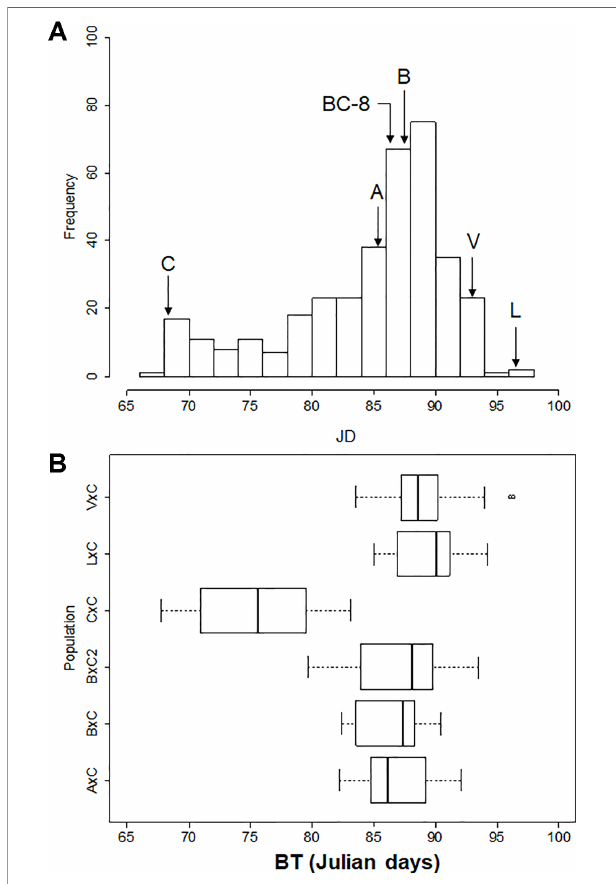
FIGURE 2 | (A) Frequency distribution of bloom time BLUP values of plant materials analyzed. Letters with arrows indicate parents ’ bloom times; ‘ Ambrunés ’ (A), ‘ Brooks ’ (B) , ‘ B×C-08 ’ (BC-8), ‘ Cristobalina ’ (C), ‘ Lambert ’ (L) and ‘ Vic ’ (V). (B) Blooming period of each population (boxes). Bold line in the boxplot indicates the median value, the left and right sides of the box represent the 25 th and 75 th percentile, respectively. Whiskers represent the lower and upper extreme